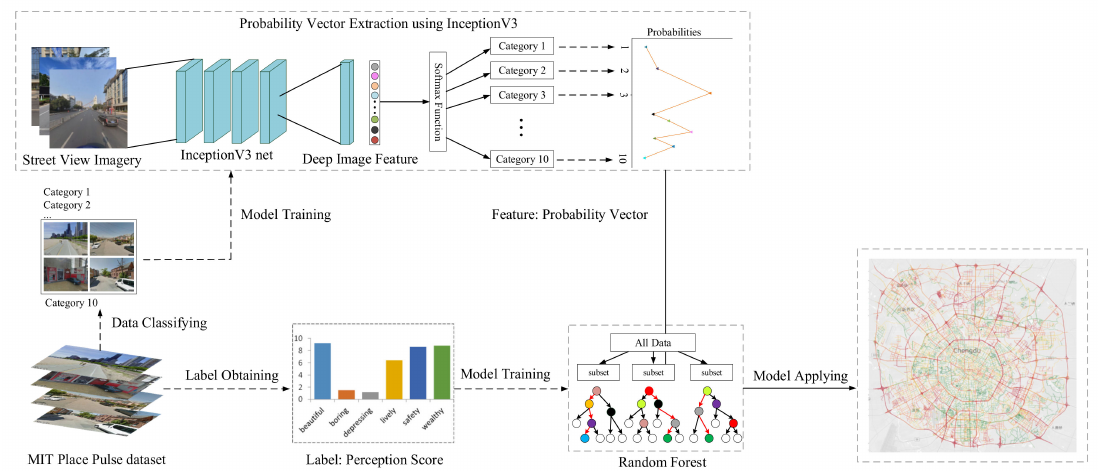
Figure 3. The system architecture of human perceptions